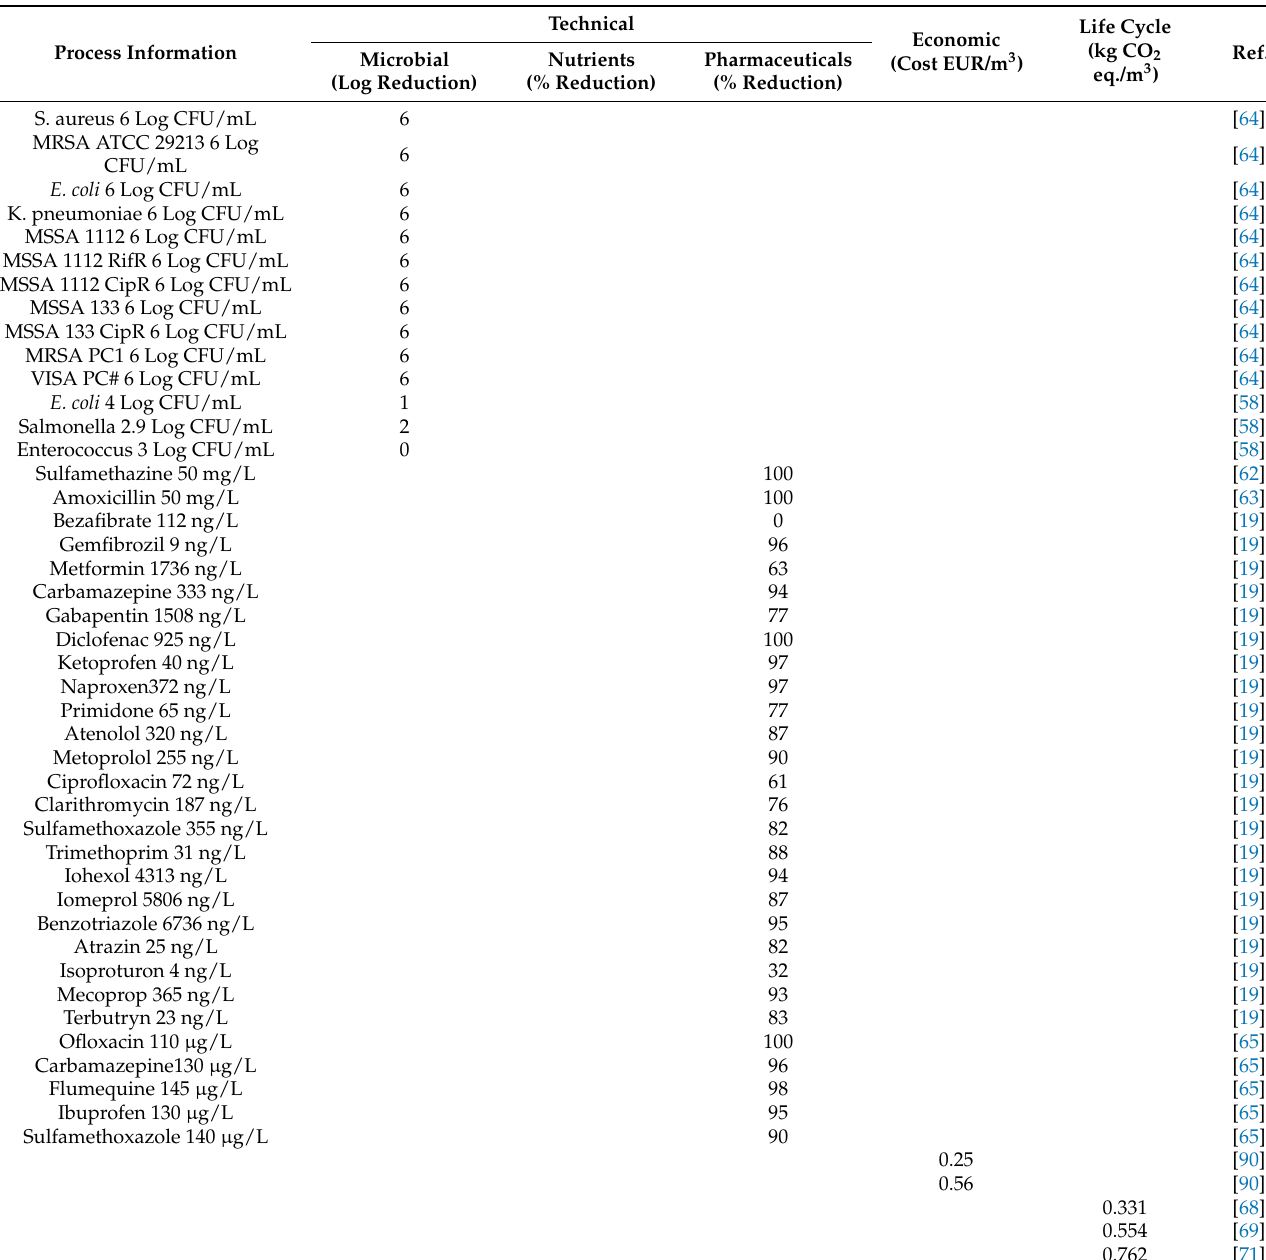
Table A7. Literature data used for scoring the Photo-Fenton